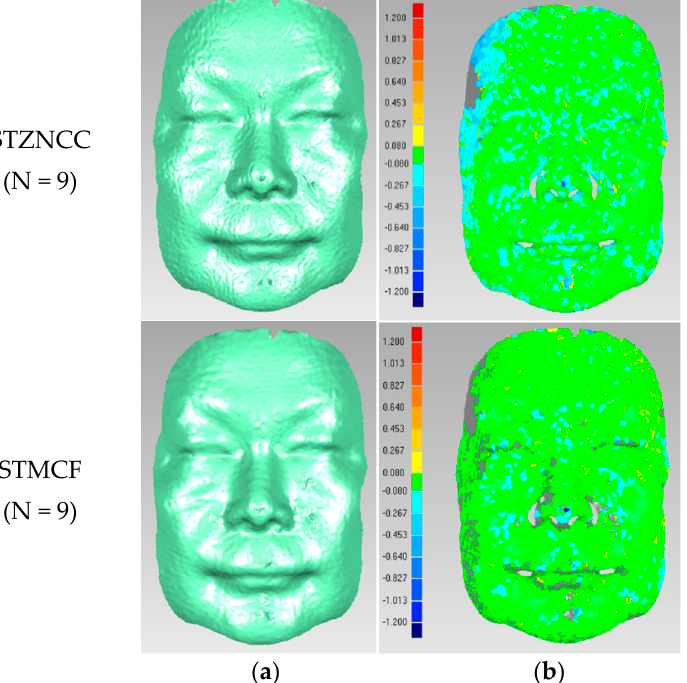
Figure 10. ( a ) 3D reconstruction result of the plastic human face (N = 9); ( b ) Corresponding error distribution map.